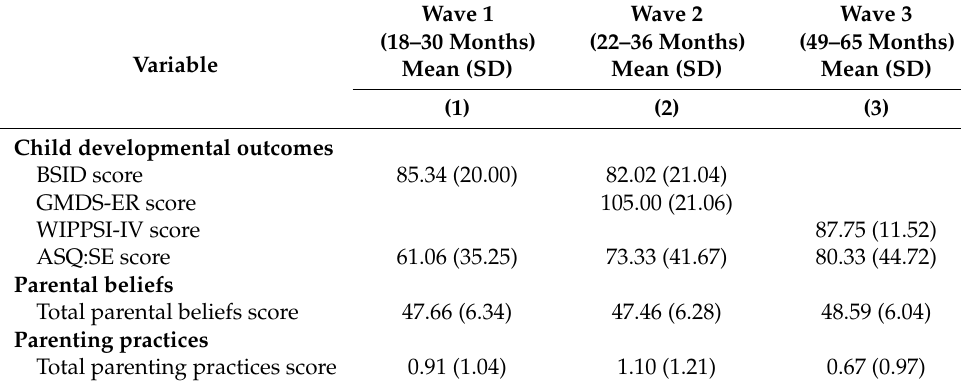
Table 3. Child development, parental beliefs, and parenting practices ( N =